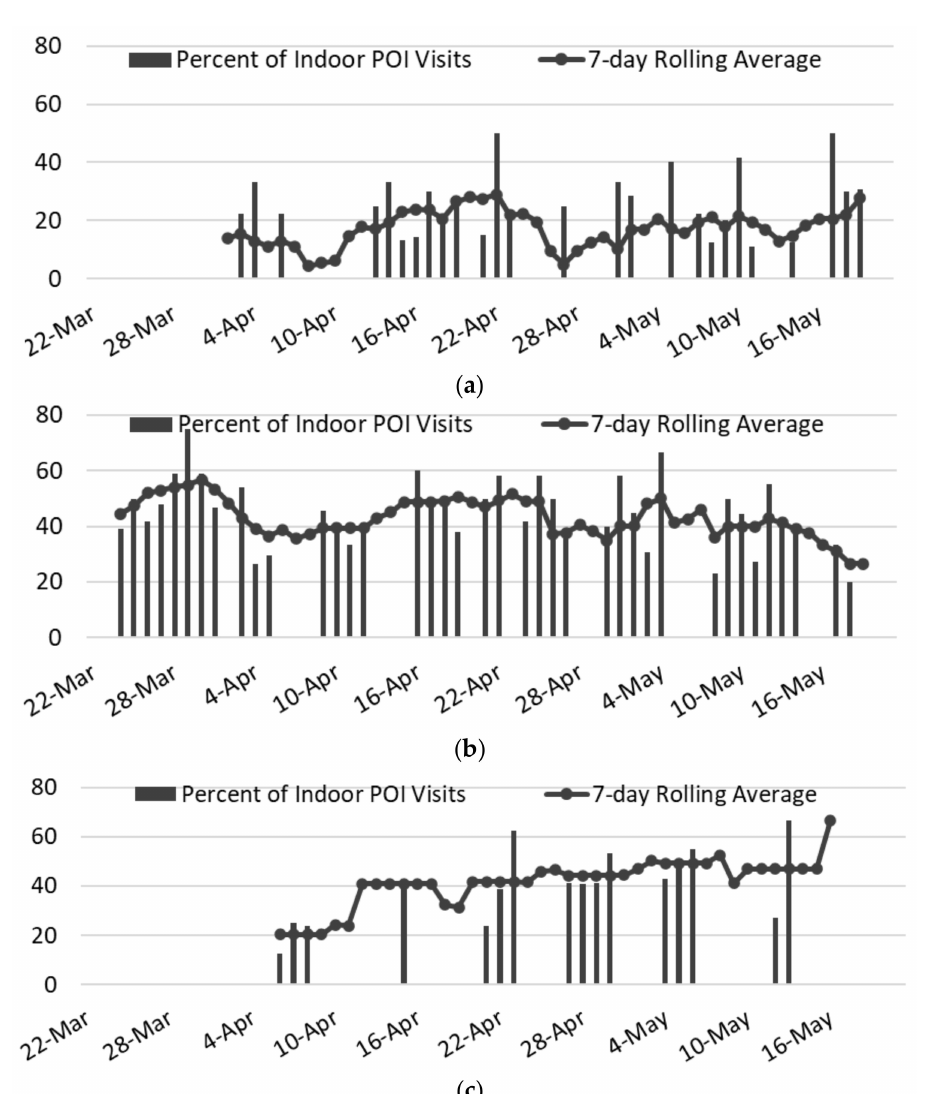
Figure 7. Percentages of people visiting an indoor POI location after leaving each of the three selected health facilities, during the DETER observation period of 22 March to 17 May 2020. ( a ) East 23rd St CityMD, SVI = 0.2083 (33 POIs 4.4–28.9%); ( b ) Wyckoff Heights Medical Center, SVI = 0.6854 (28 POIs 26.7–56.8%); ( c ) Montefiore Medical Center, weighted SVI = 0.7991 (4 POIs